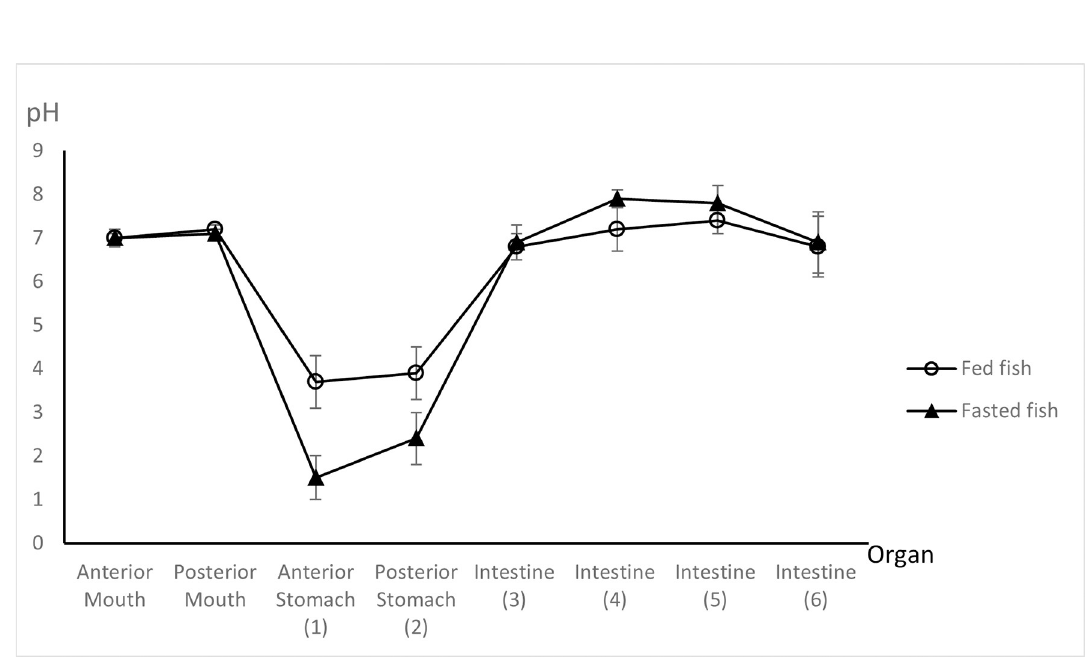
Fig 6. pH along the gastrointestinal tract of fasted and fed tilapia (mean ± SD), N = 5.